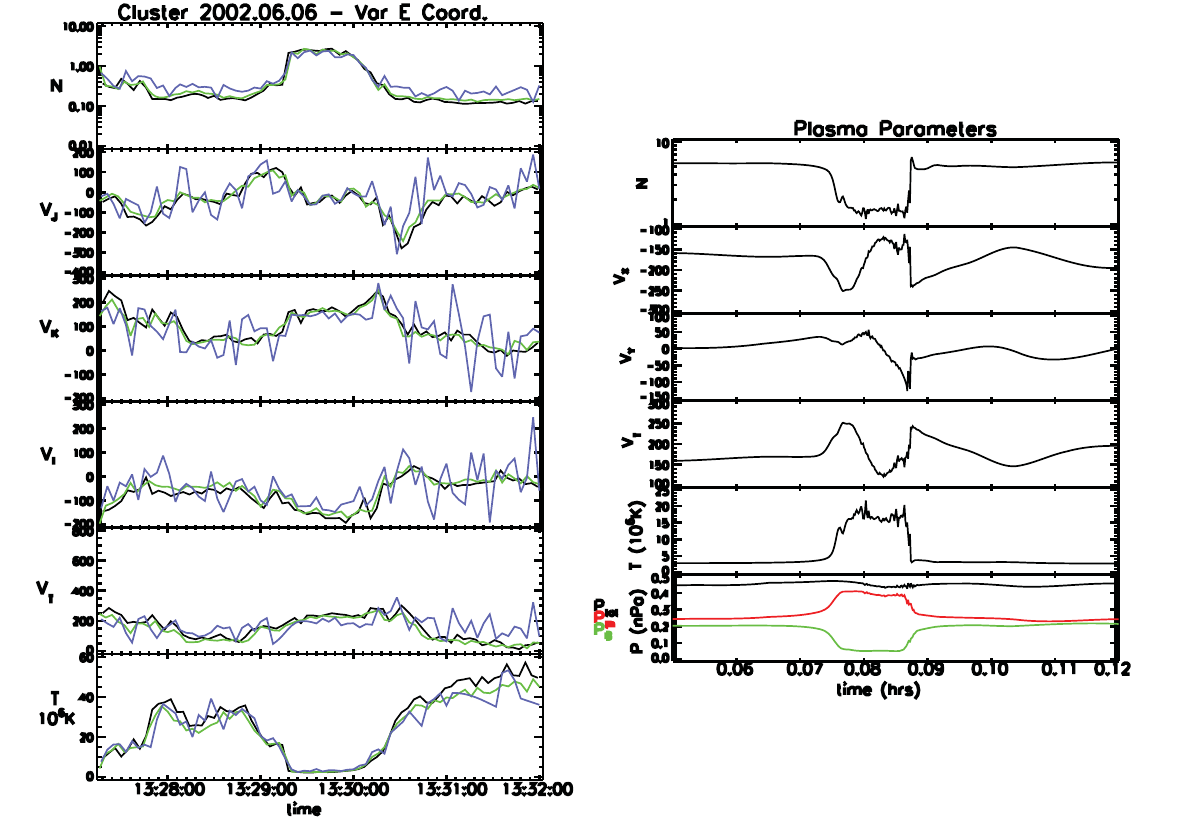
Fig. 5. Cluster and simulation plasma data for Event 3. The windows on the left display Cluster data in boundary-normal coordinates, used to determine the MSH and MSP values for the local MHD model. In order, the four spacecrafts are represented by black, red, green, and blue colors. From the top, the plot displays number density, components of velocity and total velocity and temperature. The windows on the right display the MHD simulation data. From the top, the plot displays number density, components of velocity and total velocity, temperature and components of